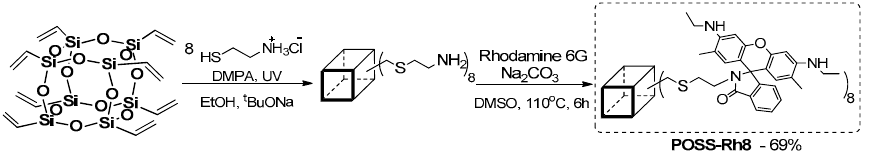
Figure 39. Reaction path towards octa-functionalized silsesquioxane with rhodamine 6G.